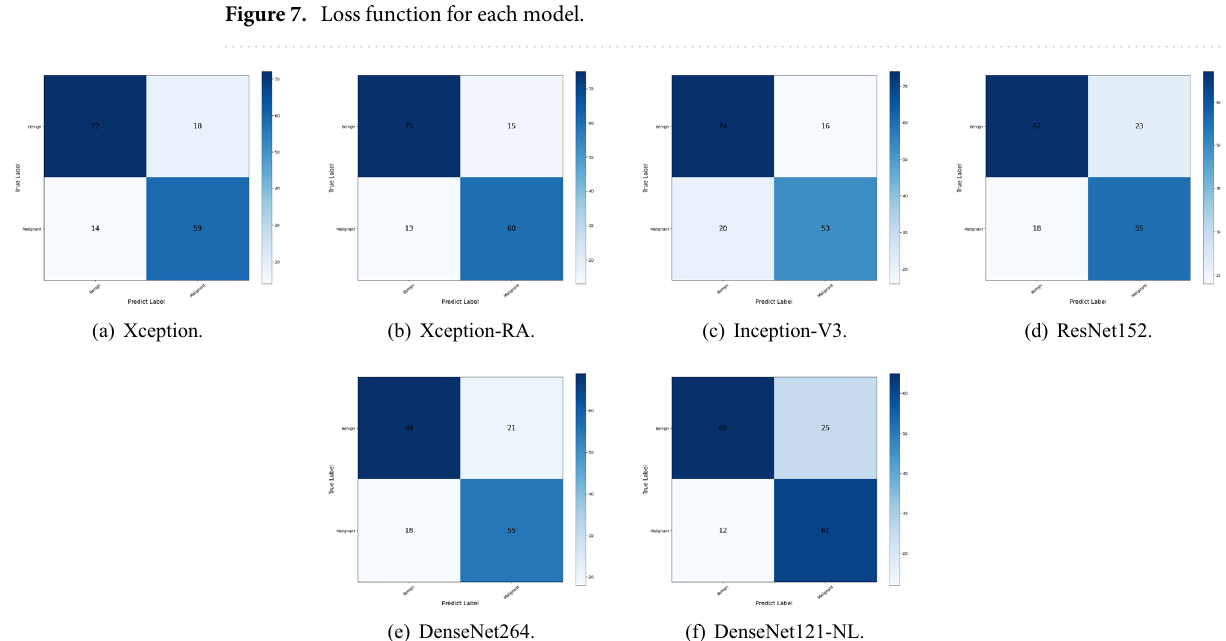
Figure 8. Confusion matrices of all comparison